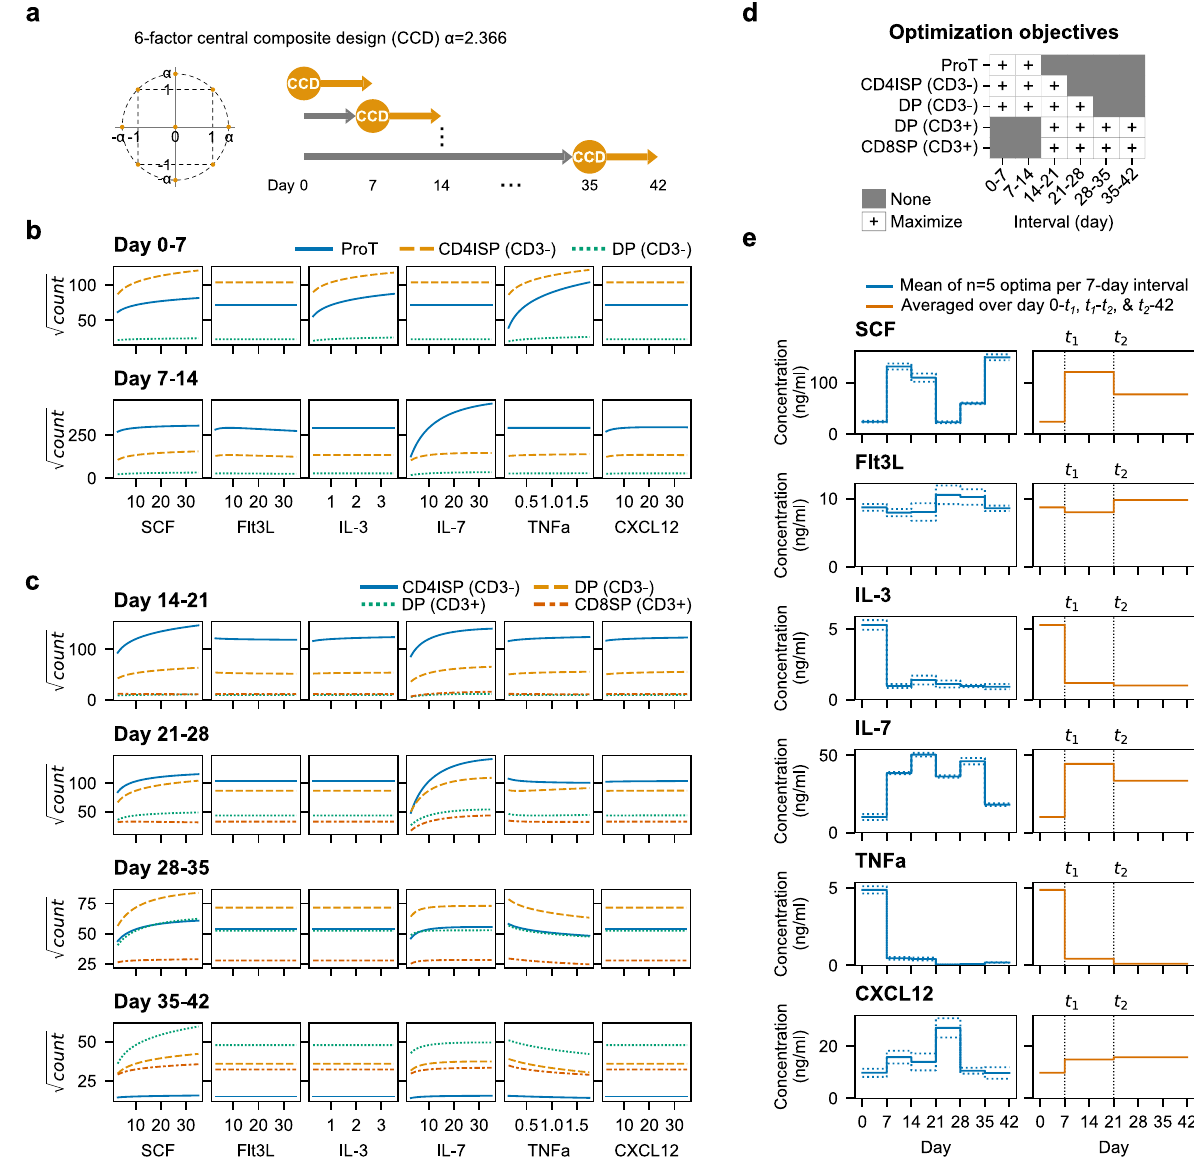
Fig. 4 SCF and IL-7 promote T-cell proliferation while TNF α inhibits maturation. a The RSM was constructed as a six-factor central composite design. Experiments were performed in 7-day intervals until day 42 to measure cytokine responses during all stages of T-cell development. b Cytokine dose responses for proT, CD4ISP, and early DP (CD3 - ) between days 0 – 7 and 7 – 14. Cells were unresponsive to IL-7 until day 7 – 14 but respond strongly to SCF, IL-3, and TNF α from day 0 – 7. c Cytokine dose responses for CD4ISP, early DP, and late DP (CD3 + ), and CD8SP for each 7-day interval between days 14 – 42. The positive dose-dependent effect of IL-3 and TNF α early in cultures fl attens and TNF α begins to inhibit the generation of DP and CD8SP cells. In ( b , c ), cytokine concentrations were swept from low to high while holding all other cytokines at their scaled center value (0). Shown are square-root transformed cell counts for each population. Experiments used n = 3 pooled UCB donors. d Objectives for optimization of RSM. Populations were either maximized or not included/present in certain 7-day intervals. e Optimized cytokines per 7-day interval (left) or as a three-stage assay (right). Solid lines are the mean of the top fi ve optimizations while dotted lines represent the standard